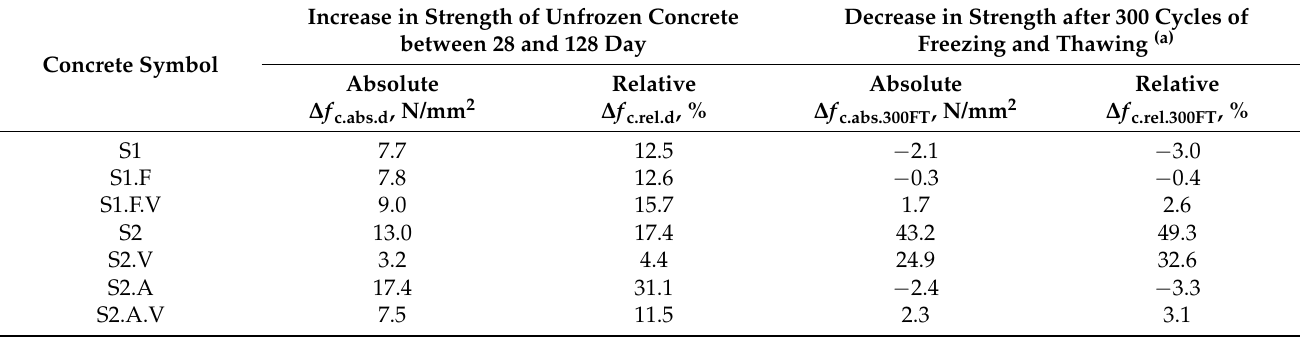
Table 7. Absolute and relative changes in compressive strength of tested types of concrete.